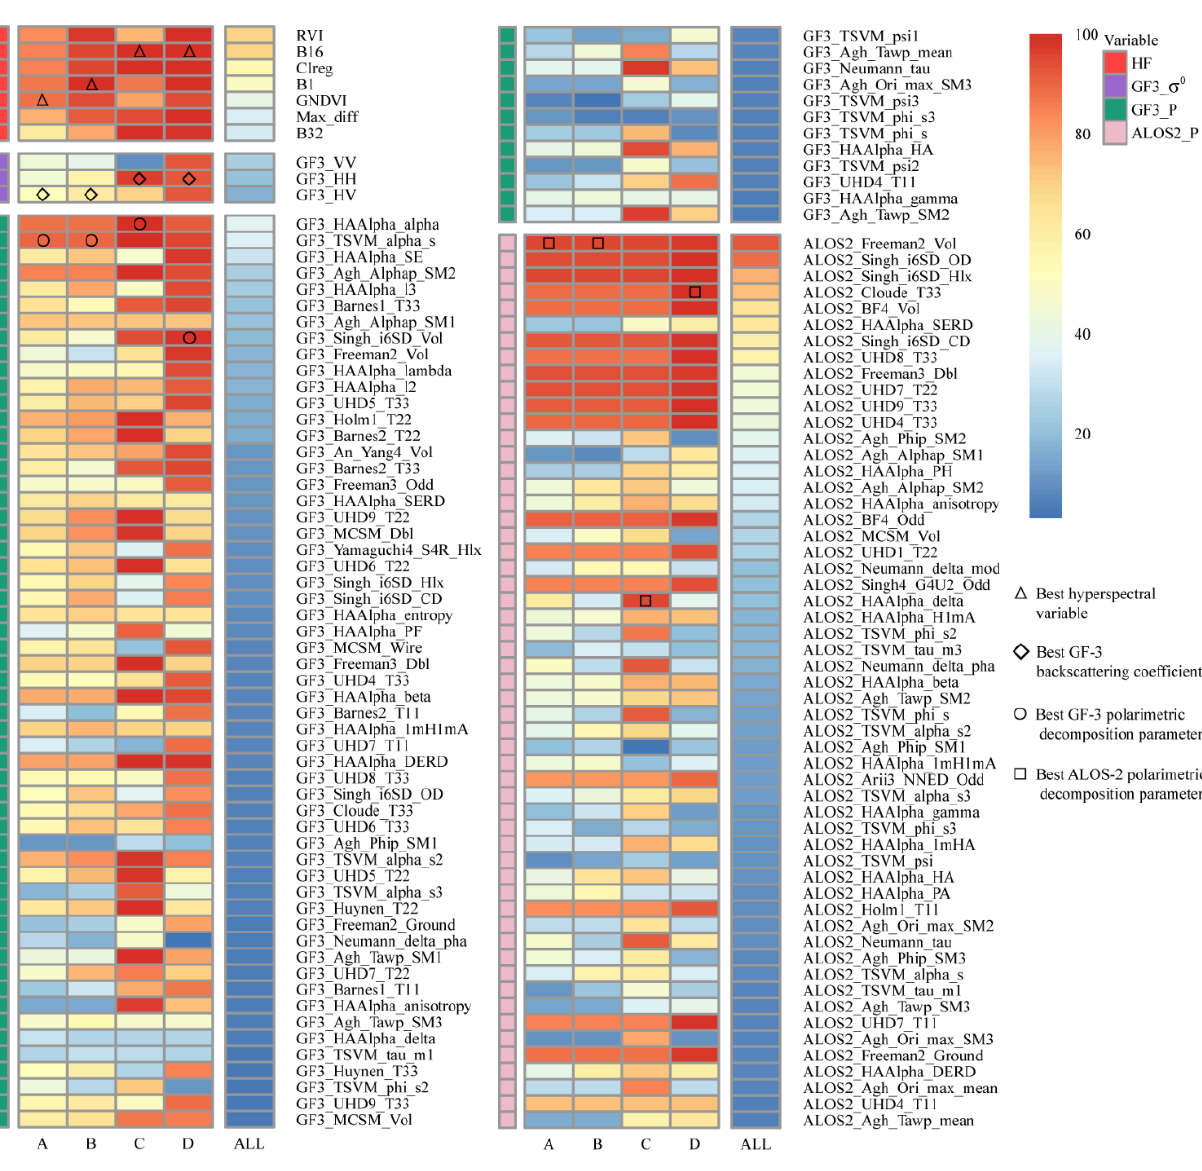
Figure 9. Contribution of feature variables to classify marsh vegetation derived from hyperspectral and quad-polarization SAR images. A, shrub; B, forest; C, deep-water marsh vegetation; D, shallow- water marsh vegetation. HF, hyperspectral Features. Table 10. Summary of the proportion of the contribution of active and passive features to marsh vegetation classification.